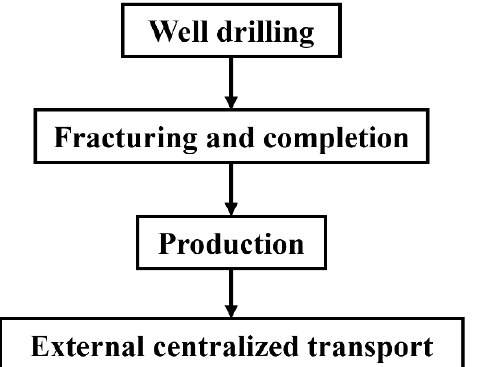
Figure 1. Production comparison between a vertical well and a horizontal well (modified from [15]).